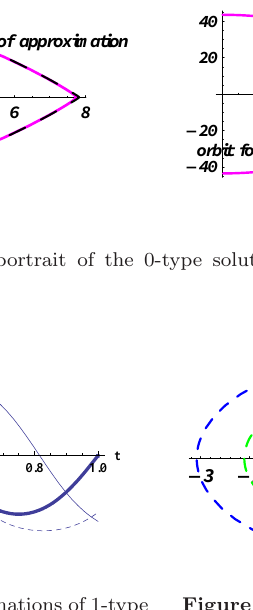
Figure 5. Some approximations of 1 -type solution.